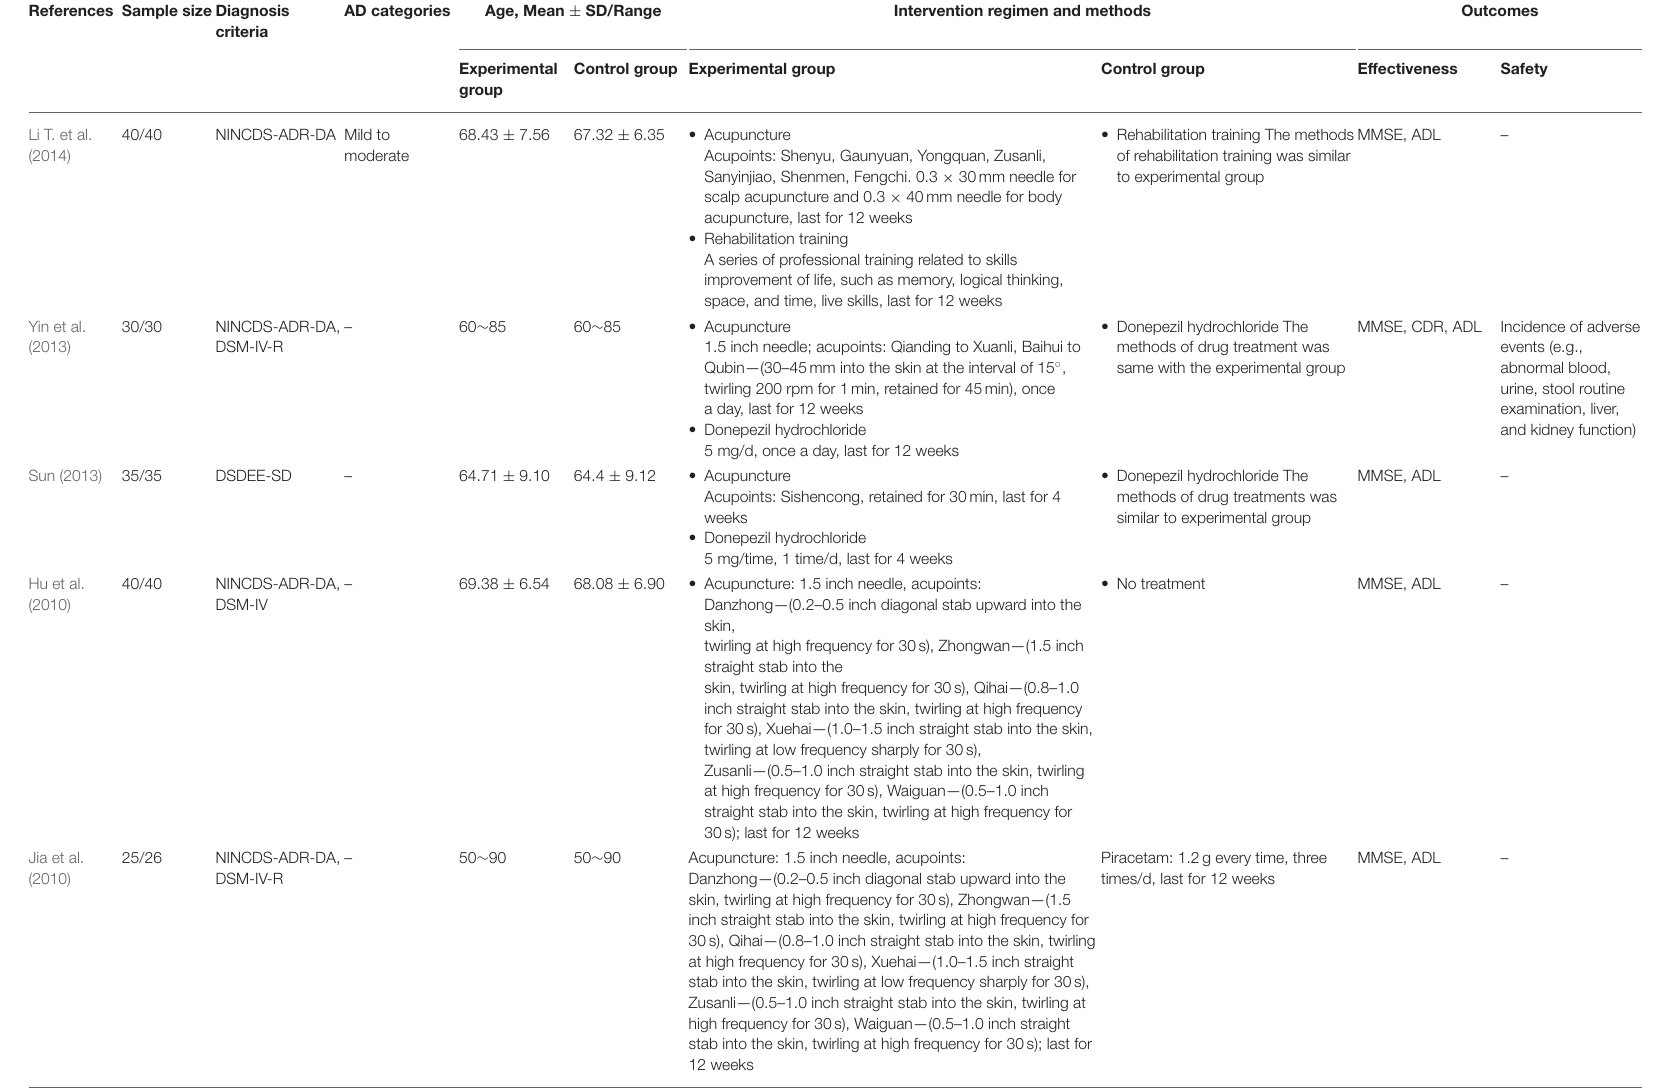
Acupuncture: 1.5 inch needle, acupoints: Danzhong—(0.2–0.5 inch diagonal stab upward into the skin, twirling at high frequency for 30s), Zhongwan—(1.5 inch straight stab into the skin, twirling at high frequency for 30s), Qihai—(0.8–1.0 inch straight stab into the skin, twirling at high frequency for 30s), Xuehai—(1.0–1.5 inch straight stab into the skin, twirling at low frequency sharply for 30s), Zusanli—(0.5–1.0 inch straight stab into the skin, twirling at high frequency for 30s), Waiguan—(0.5–1.0 inch straight stab into the skin, twirling at high frequency for 30s); last for 12 weeks